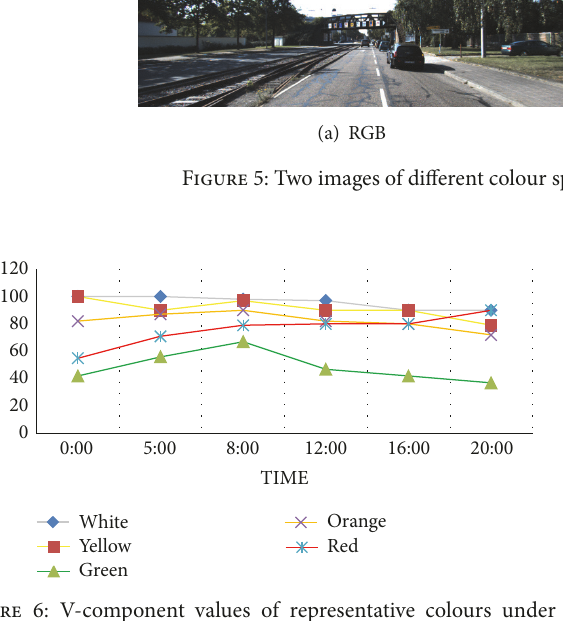
Figure 6: V-component values of representative colours under various